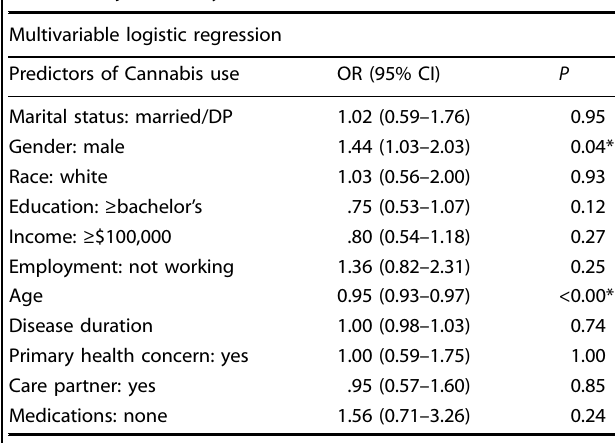
Table 2. Adjusted analysis of Cannabis